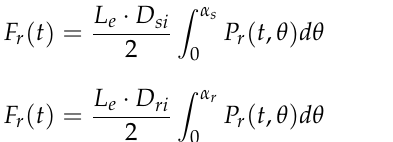
Figure 5. Effect of the slots. ( a ) Variation of the radial permeance due to the effect of a slot; ( b ) magnetic field in slotless and slot stators.